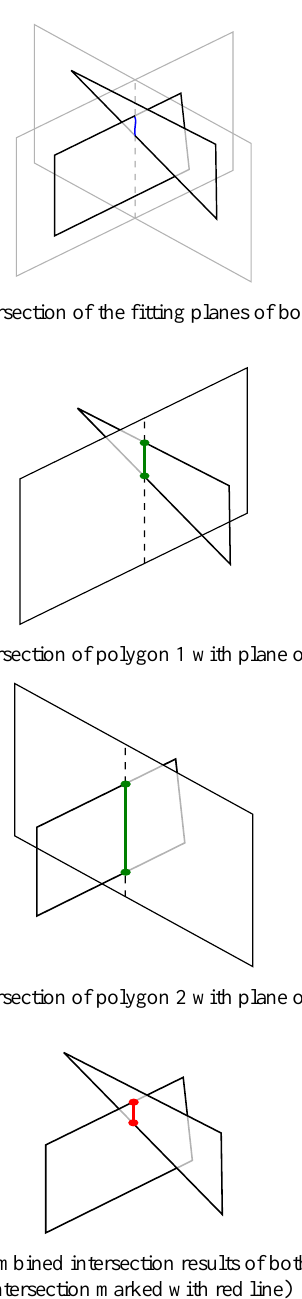
Figure 11: Initial position. A triangle (polygon 1) intersects with a quadrangle (polygon 2)